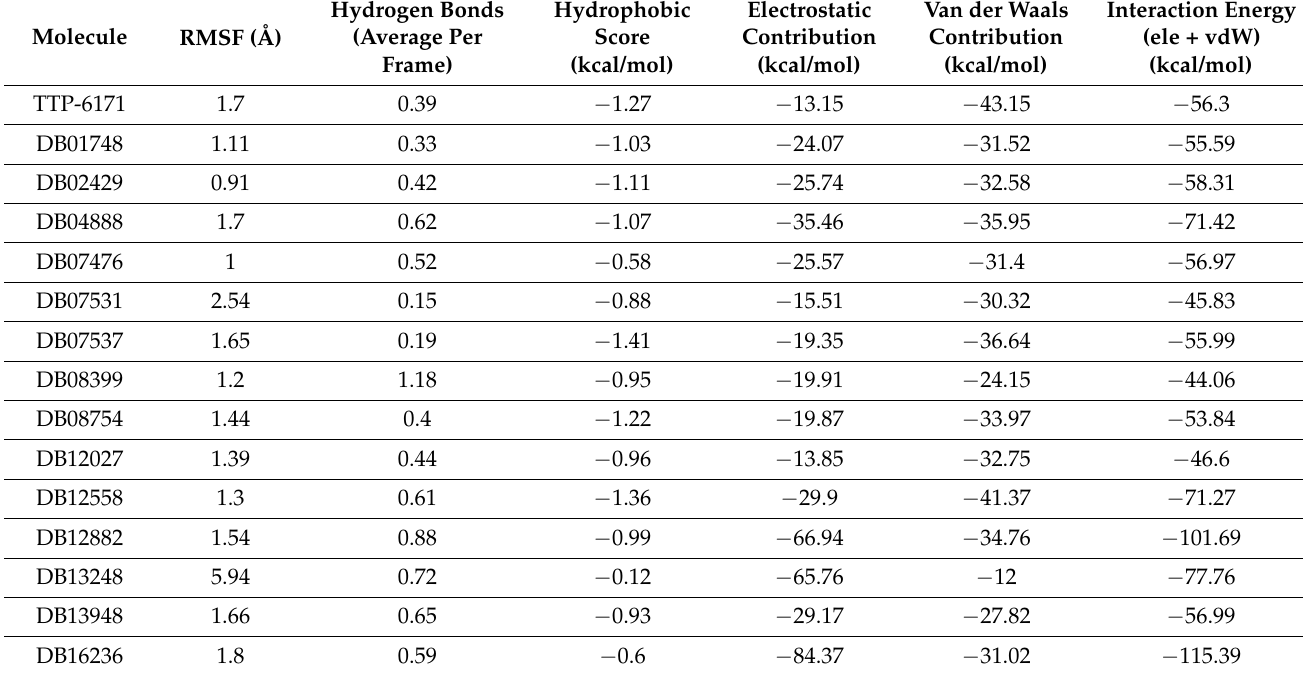
Table 1. Summary of principal descriptors extracted from the MD-based post-docking refinement of virtual screening derived poses for the 14 selected compounds, plus the reference TTP-6171 pose. The ligand RMSF, the average number of hydrogen bonds for each trajectory frame, the hydrophobic score, electrostatic and van der Waals contribution to the protein–ligand interaction energy, and the total interaction energy are reported. All descriptors are mediated across three independently run MD